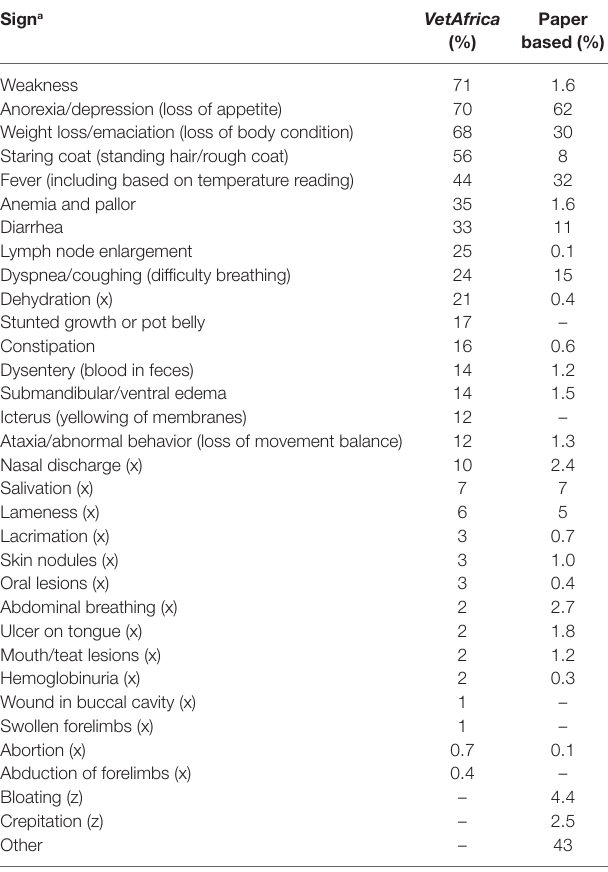
a Signs that have an “x” after them indicate “optional” signs listed in the VetAfrica interface (i.e., they may be recorded as being observed but are not considered in the differential disease diagnostic process carried out by the VetAfrica app). Those followed by a “z” indicate signs that do not appear at all in any VetAfrica